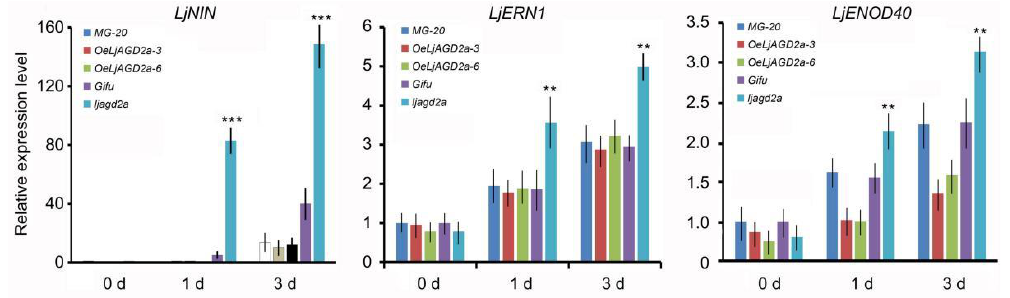
Figure 8. Levels of transcript of nodulin genes — the nodule inception gene ( LjNIN ), ERF required for nodulation 1 ( LjERN1 ) and early nodulin gene ( LjENOD40 ) — in OeLjAGD2 plants and mutants. The expression of LjNIN , LjERN1 and LjENOD40 was increased in ljagd2a mutants after inoculation with M. loti , but overexpression of LjAGD2a did not change the expression of nodulin genes. The data were normalized using expression of Actin as an internal control. The Actin-normalized value for the 0-day wildtype sample was set to 1. Presented data are averages of triplicate RNA prepara- tions ( n = 15, ±SD). ** and *** indicate p < 0.01 and p < 0.001, respectively, according to the Duncan test.